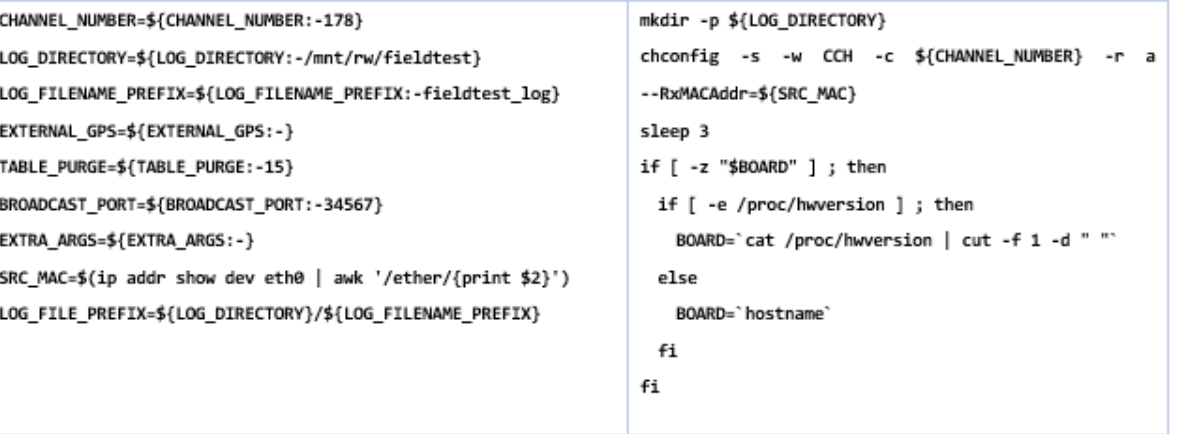
Figure 21. Initialization of the communication process.